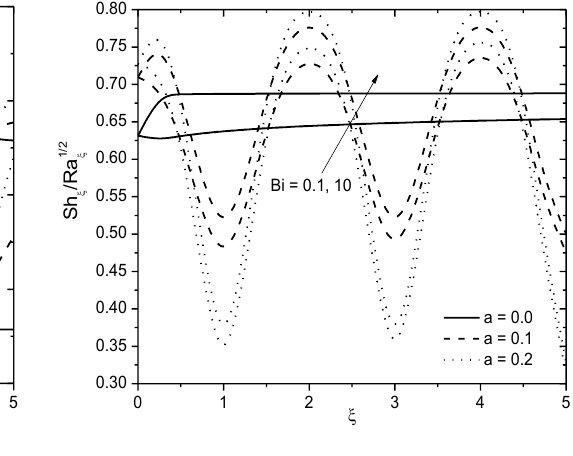
Figure 15. Effects of Bi and a on local regular Sherwood